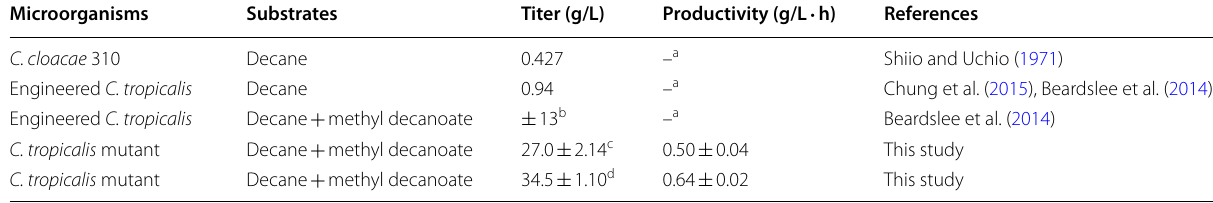
a Not enough information b Decane induction by single bolus addition of 10 g/L decane (induction time: 6 h) c Decane induction by single bolus addition of 1% v/v decane (induction time: 10 h) d Decane induction by substrate limitation condition/continuous feeding (0.65 g/L/h decane for 10 h)